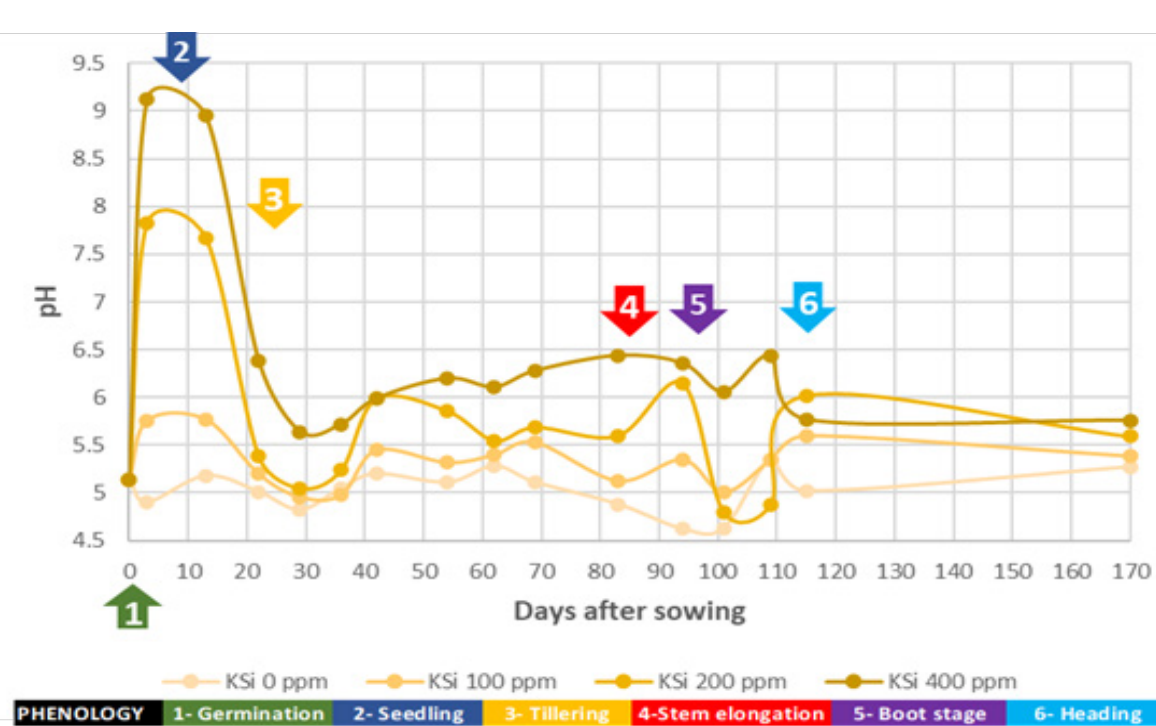
Figure 6 . Fluctuation of soil pH for all potassium silicate treatments (KSi Xppm) during the field stage of the